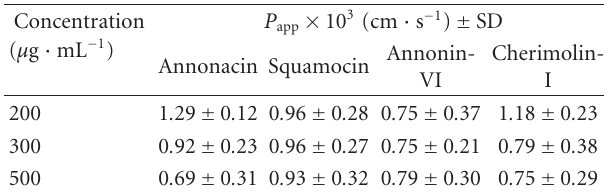
Figure 4: Intestinal absorption of annonacin, squamocin, annonin- VI and Cherimolin-1 in rats. ACGs-SD was administered at a dose of 200, 300, 500 μ g/mL to a 10 cm-long jejunum loop and the intestinal absorption rate (%) was estimated by measuring the remained amount of ACGs in the loop 2h after administration. ( n = 5). Table 3: The permeability ( P app , Mean ± SD, n = 6) at di ff erent perfusate concentration.